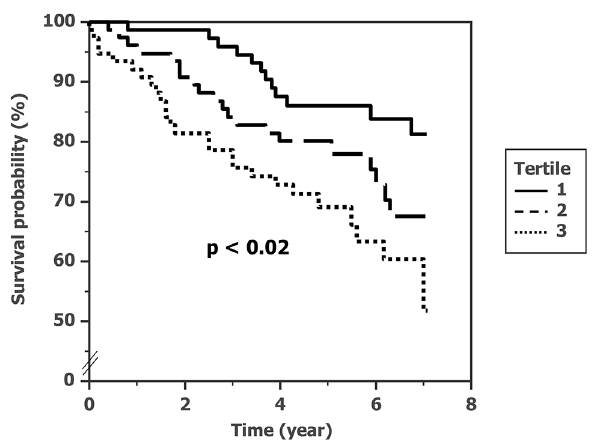
Figure 1. Event-free ratio among the tertiles of plasma BNP in subjects with